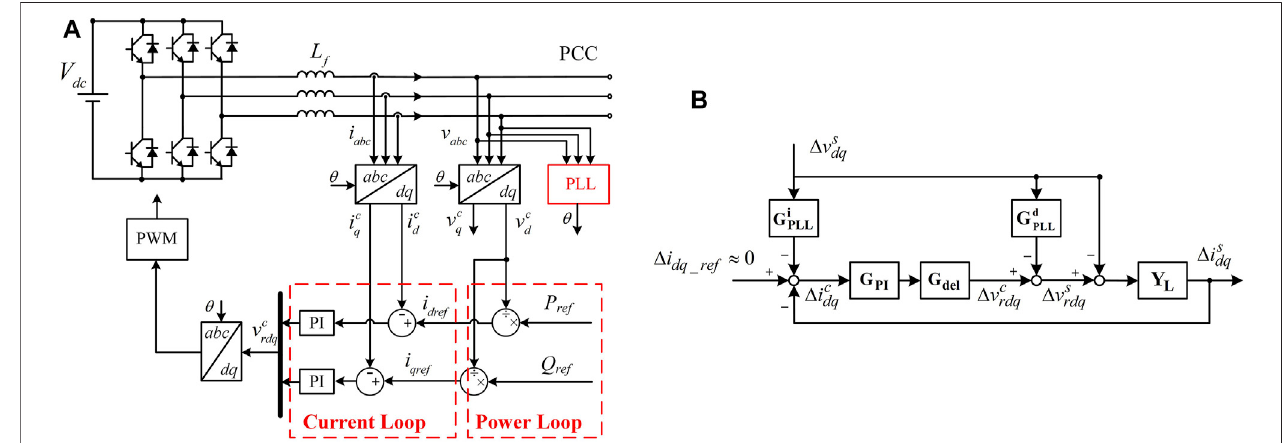
FIGURE 1 | PQ node con fi guration and impedance model: (A) con fi guration, (B) impedance